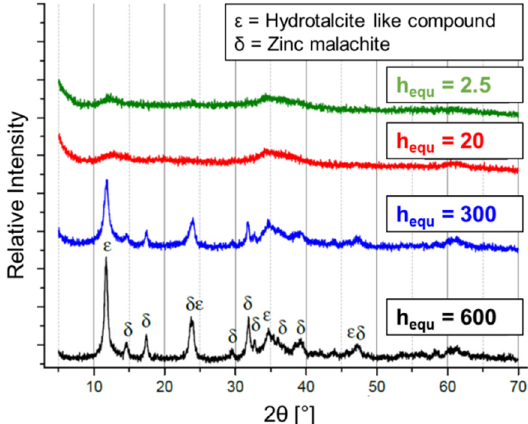
Figure 9. PXRD patterns of the dried catalyst precursors depending on the hydrolysis equivalents added (h equ ). Catalyst system: Cu 0.61 Zn 0.21 Al 0.18 .